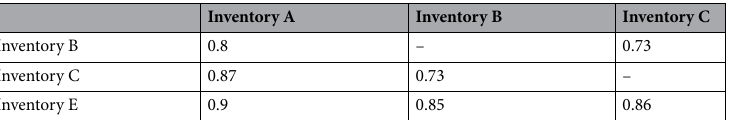
Table 3. Error index defined in Eq. (1), after Carrara et al. 37 , Alvioli et al. 38 and Fiorucci et al. 10 , calculated for the four polygon-based inventories in the overlap region. A smaller error index denotes better spatial agreement between the corresponding pair of inventories.